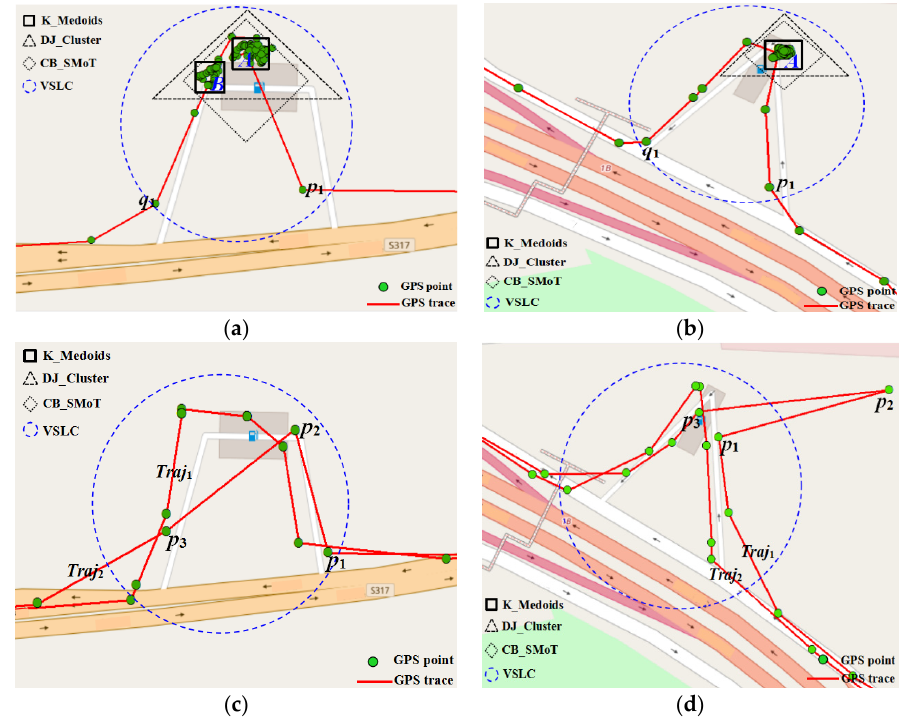
Figure 7. Comparison analysis of the refueling stops extraction results of the different algorithm. ( a ) Vehicle leaves many stop points; ( b ) Vehicle leaves many stop points only when entering gas station; ( c ) Few stop points and track points missing; and ( d ) Trajectory noises.